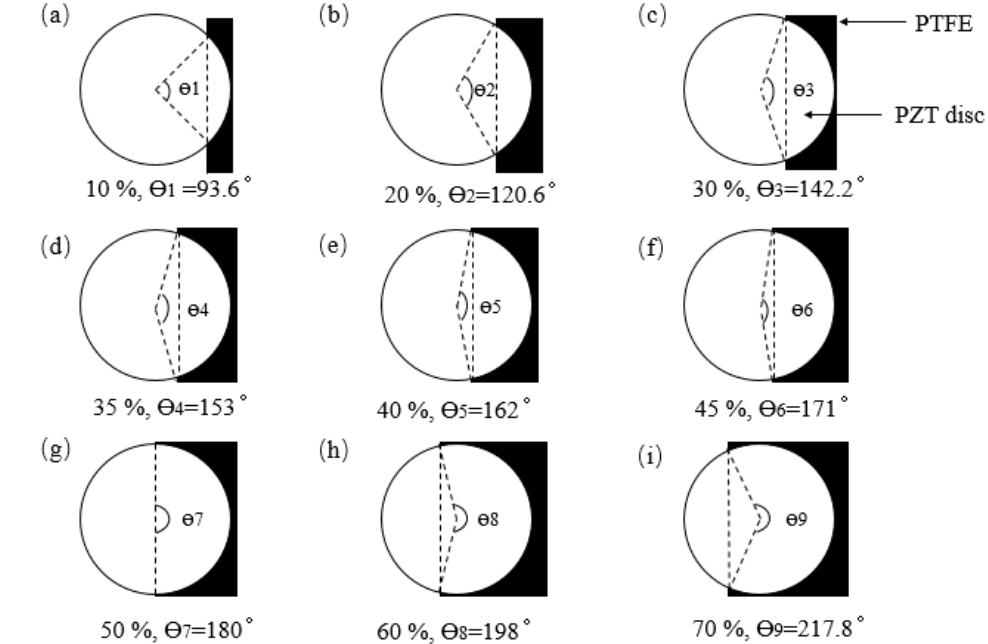
Table 1. The corresponding values of debonding areas and Ɵ i (I = 1,2,…,9) when the debonding areas of actuator set from 10% to 70%.